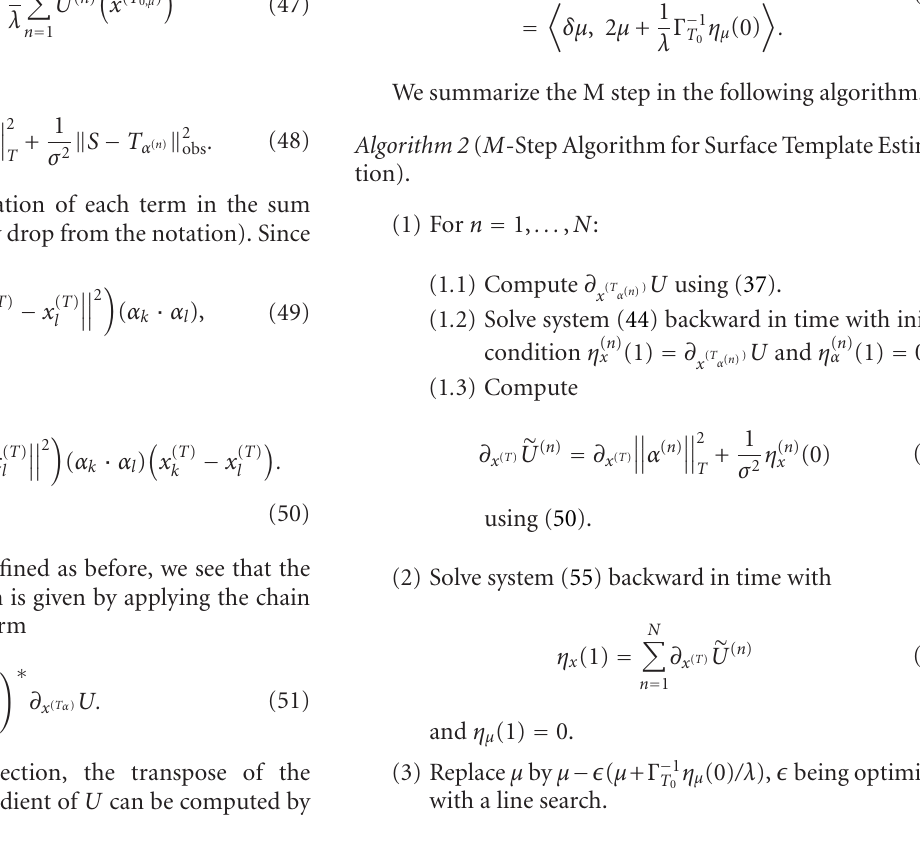
Algorithm 2 ( M -Step Algorithm for Surface Template Estima-